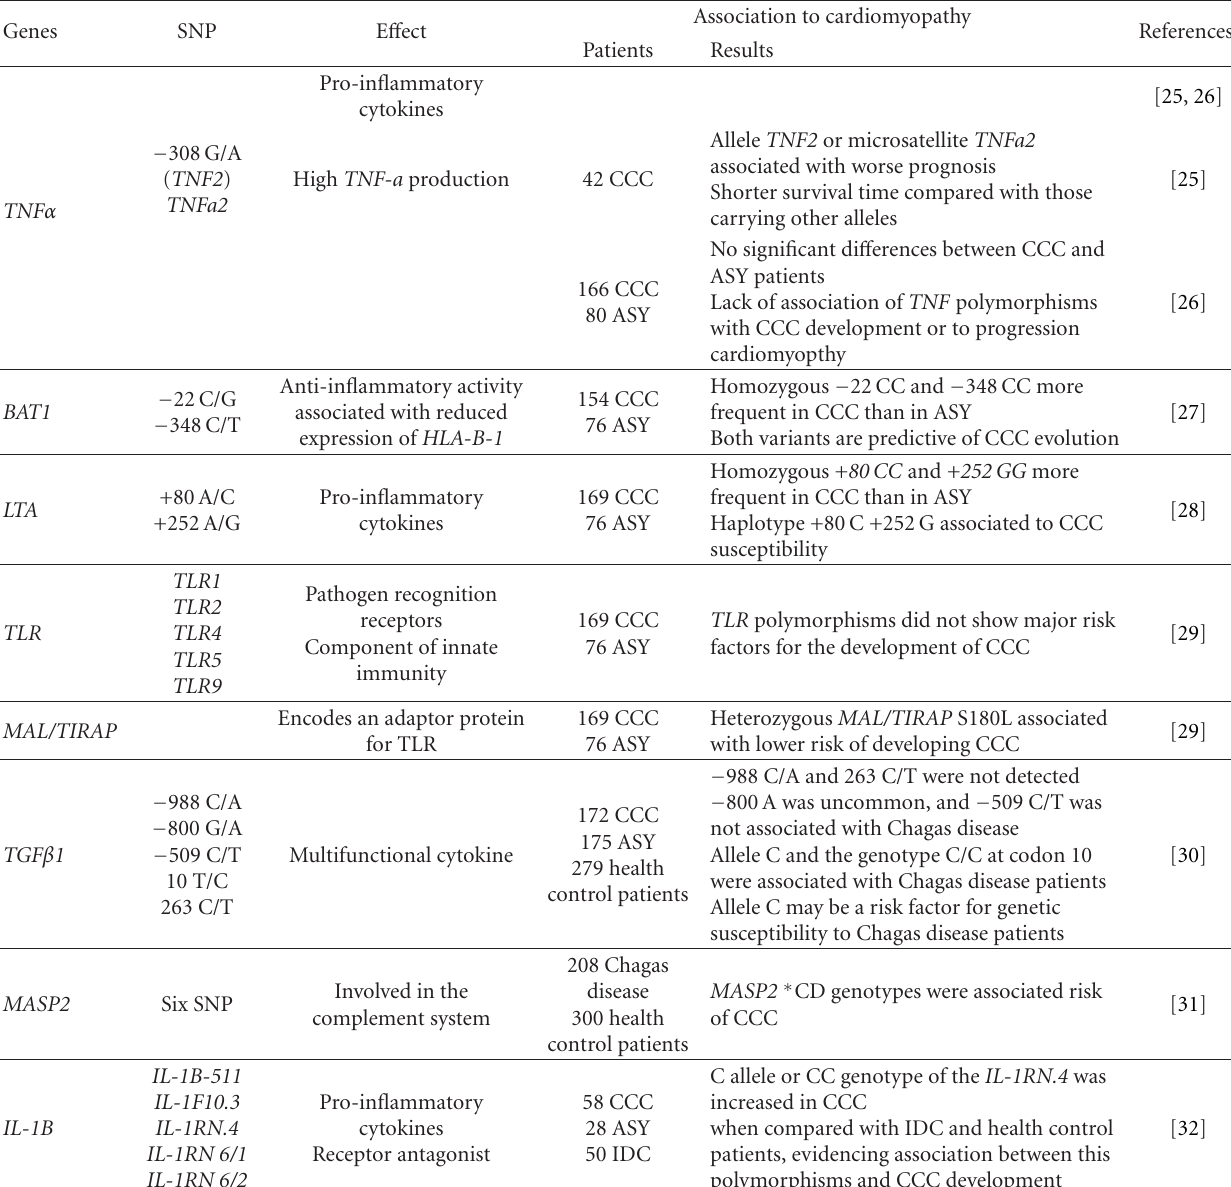
Table 1: Genetic polymorphisms in Chagas disease